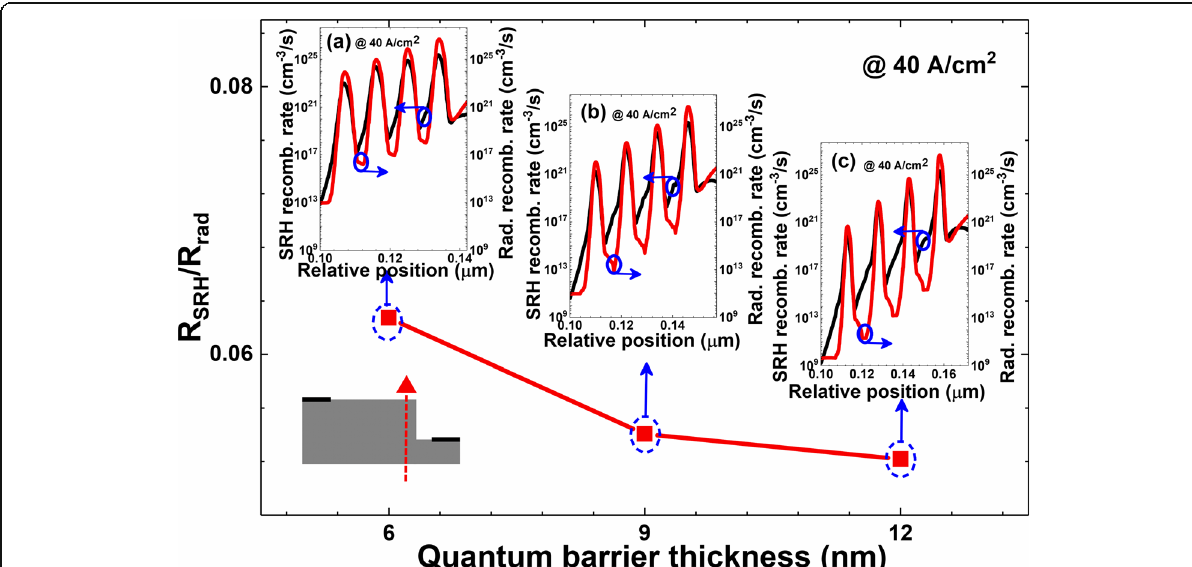
Fig. 5 Ratios of integrated SRH recombination (SRH) rate and integrated radiative recombination rate for μ LEDs A, B, and C. Insets ( a ), ( b ), and ( c ) are the profiles for SRH recombination (SRH) rate and the radiative recombination rate at the mesa edge for μ LEDs A, B, and C, respectively. Data are calculated at the current density of 40 A/cm